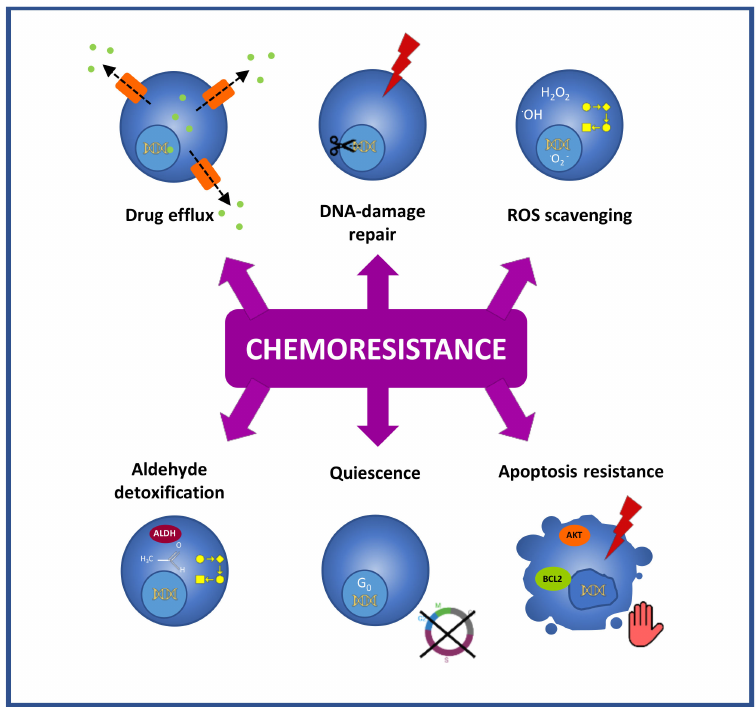
Figure 2. Chemoresistance mechanisms exhibited by gCSCs. gCSCs evade the effects of treat- ments through different mechanisms, such as active drug efflux, high DNA repair activity, efficient ROS scavenging, the high detoxification of aldehydes, their quiescence status, and apoptosis resis- tance